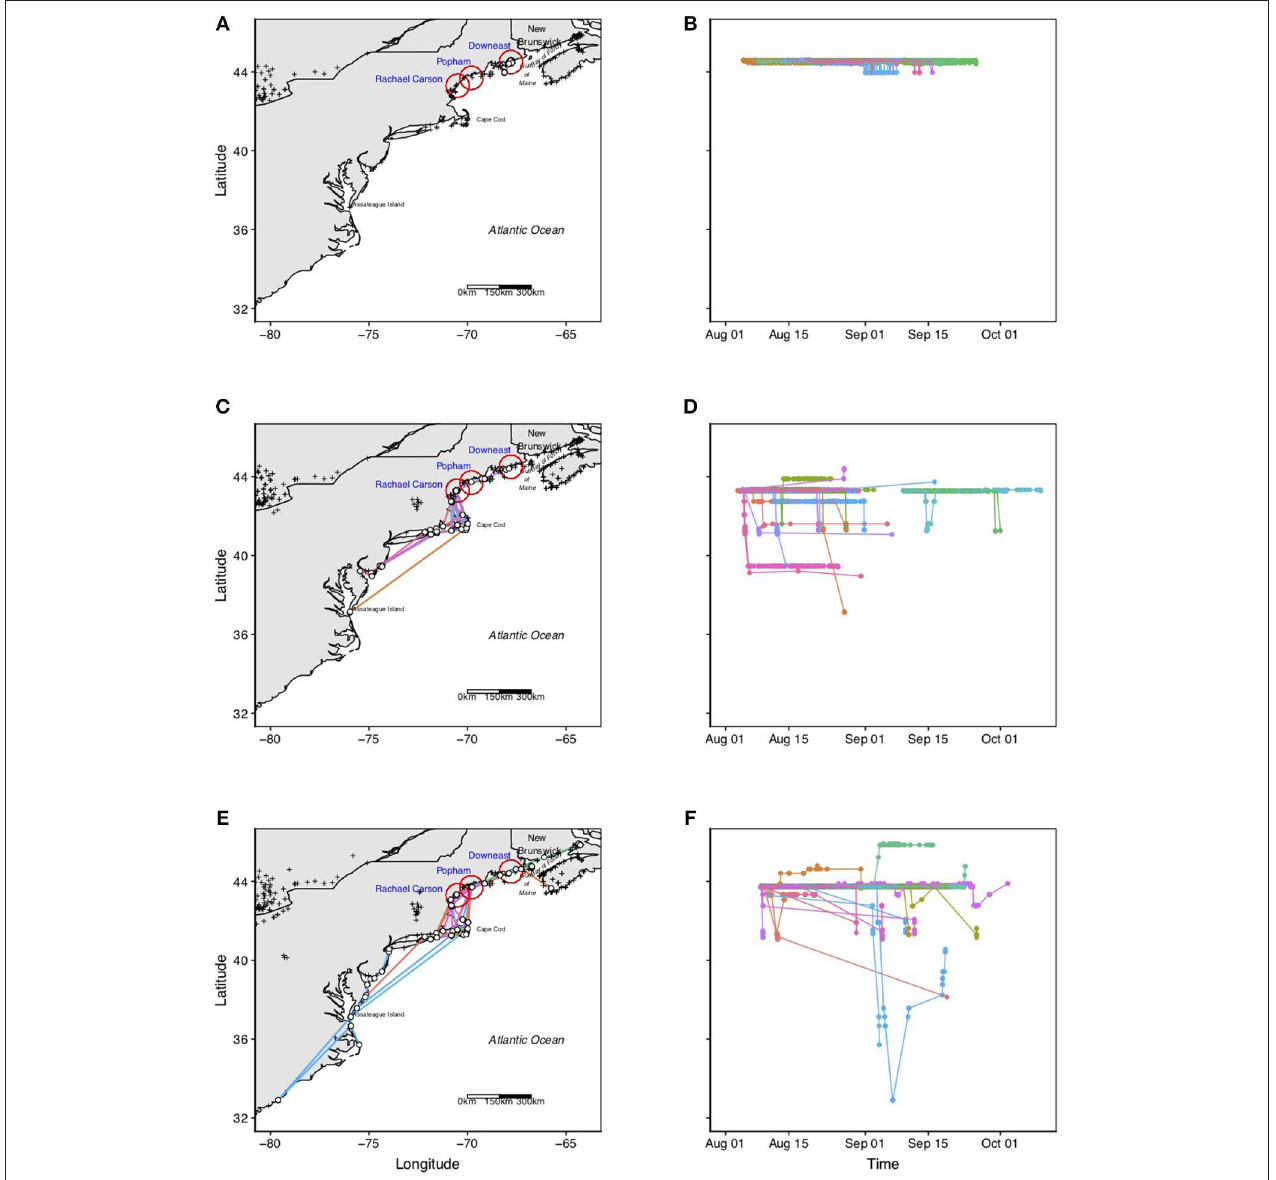
FIGURE 4 | Plots showing spatial as well as temporal post capture movements of individual Semipalmated Sandpipers (ages, years pooled) tagged at each of the three tagging locations: “Downeast” (A,B) , “Popham” (C,D) , and “Rachel Carson” (E,F) . Crosses represent locations of Motus towers present during each of the deployment periods. White dots represent towers where Semipalmated Sandpipers were detected. Colored lines represent tracks of different individual birds, and are consistent within a given site. Sample sizes and detailed information about each site’s activities are provided in the text. Note that no birds tagged at the Downeast stopover site in Pleasant Bay were detected beyond the local tagging area, suggesting that these birds initiated trans-oceanic flights from this area. In contrast, more than 50% of the birds tagged at Popham Beach and Rachel Carson NWR were detected to the north (few) and to the south (many), with birds concentrating in coastal southern New England (Cape Cod and the islands, Rhode Island, Long Island Sound) before their final detection, suggesting that this site is also a major departure area for birds making trans-oceanic flights to wintering grounds in eastern South America. A few birds were detected as far south as Delaware Bay, the Carolinas and